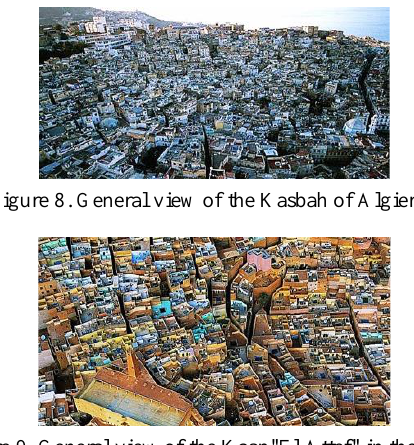
Figure 9. General view of the Kasr "El Attef" in the M'zab (Gouaich et al., 2018)